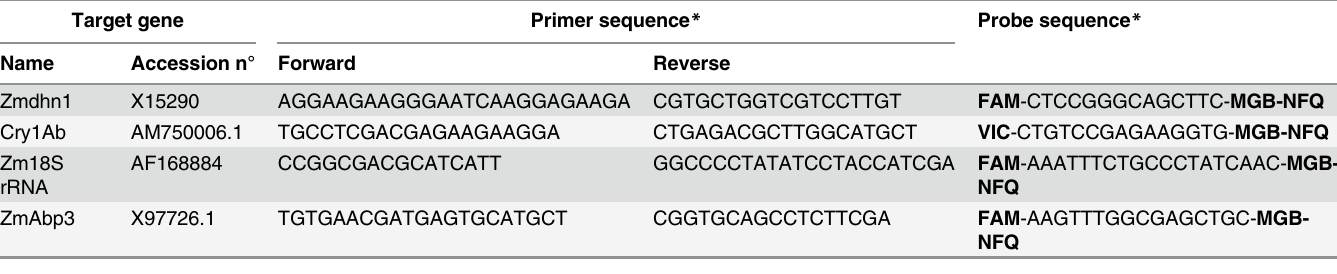
Table 1. Primer and probe sequences utilised for the expression analysis of the target genes by qRT-PCR. Target